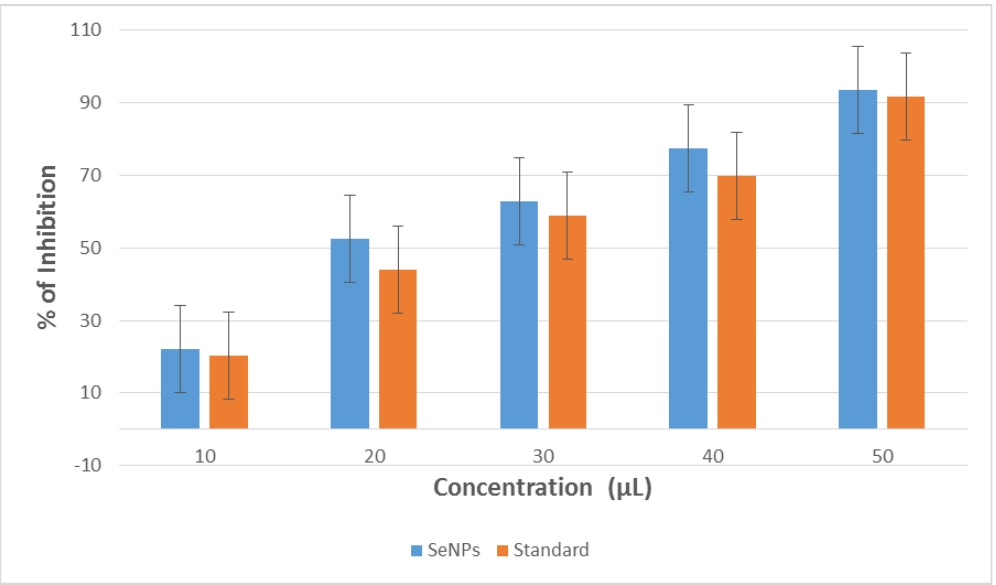
Figure 6. DDPH antioxidant assay of AgNPs produced with Ulvan from Ulva lactuca.